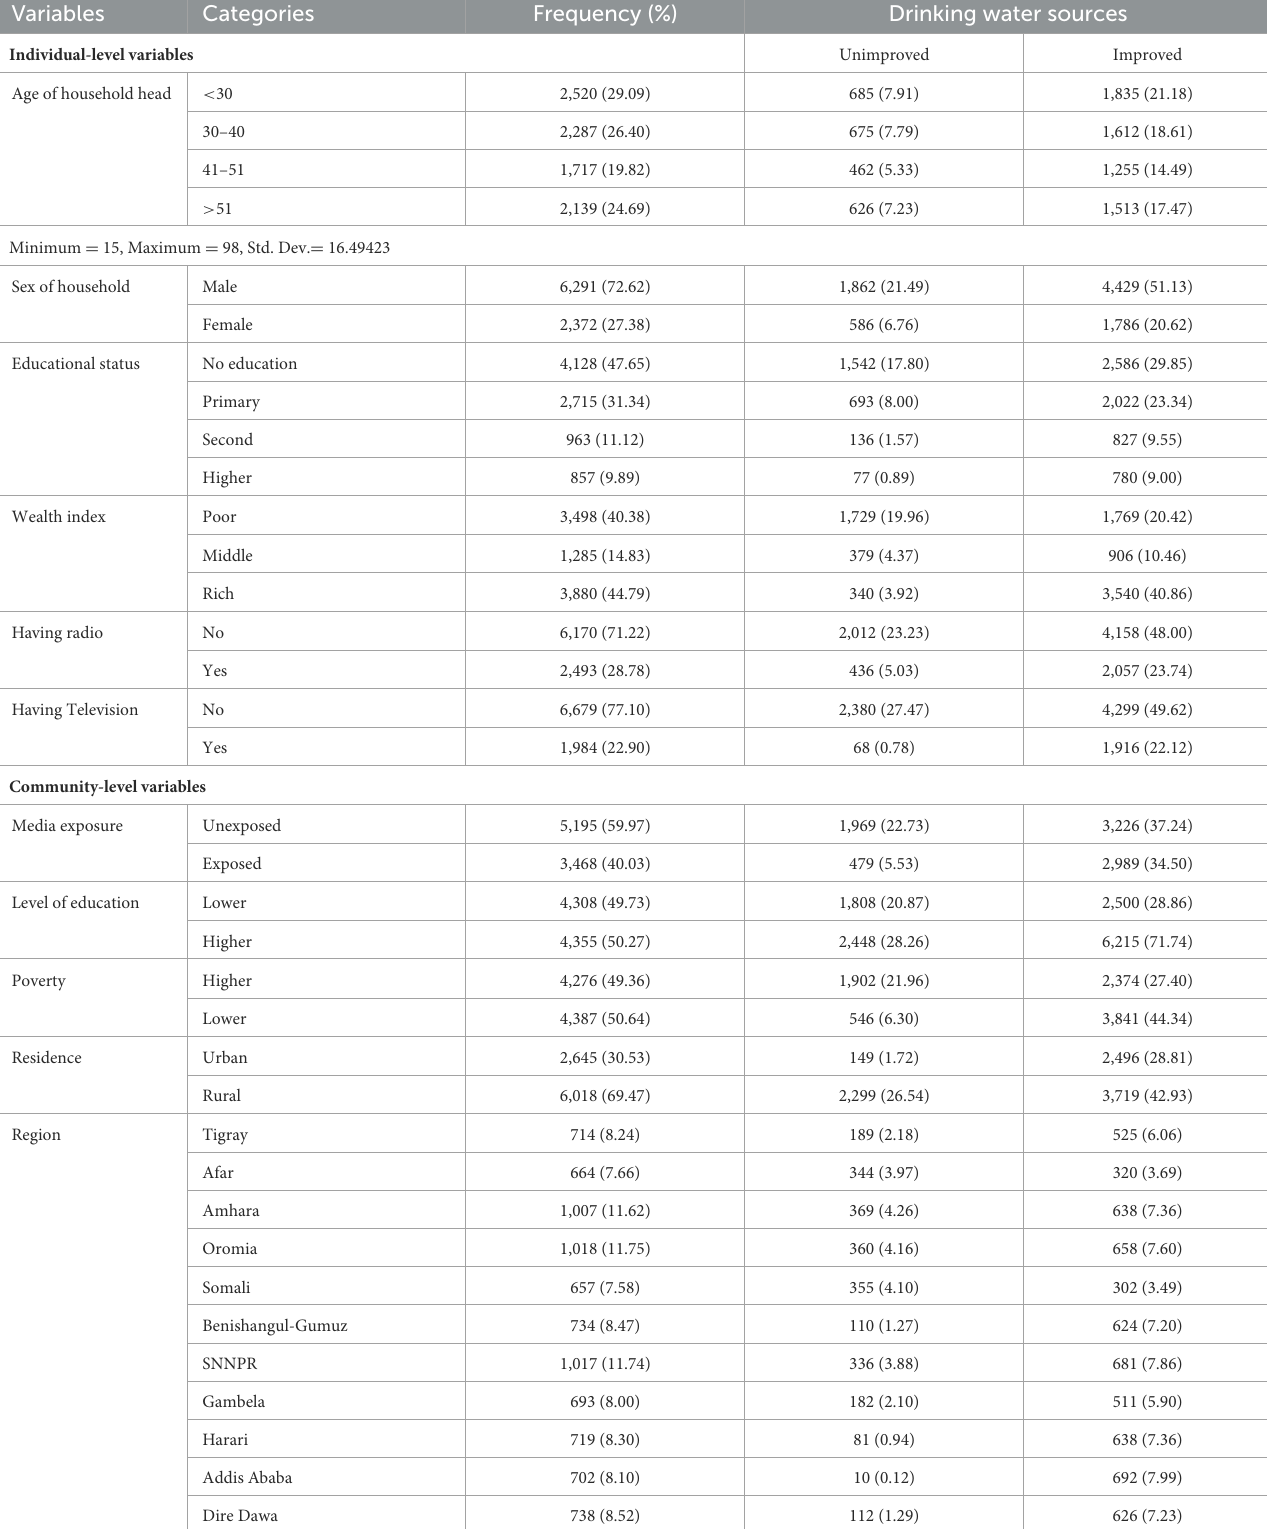
TABLE 1 Socio-demographic characteristics of study